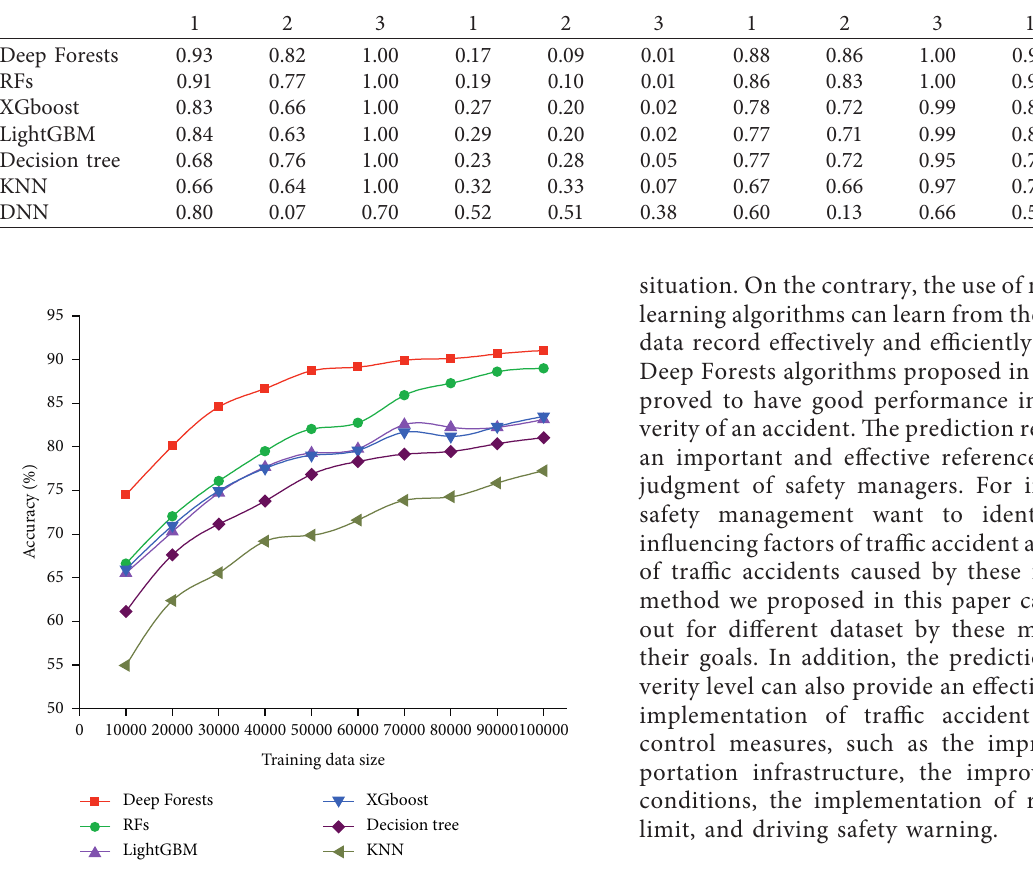
Table 4: The predictive performance of different accident categories. Recall False alarm rates F1 score ROC